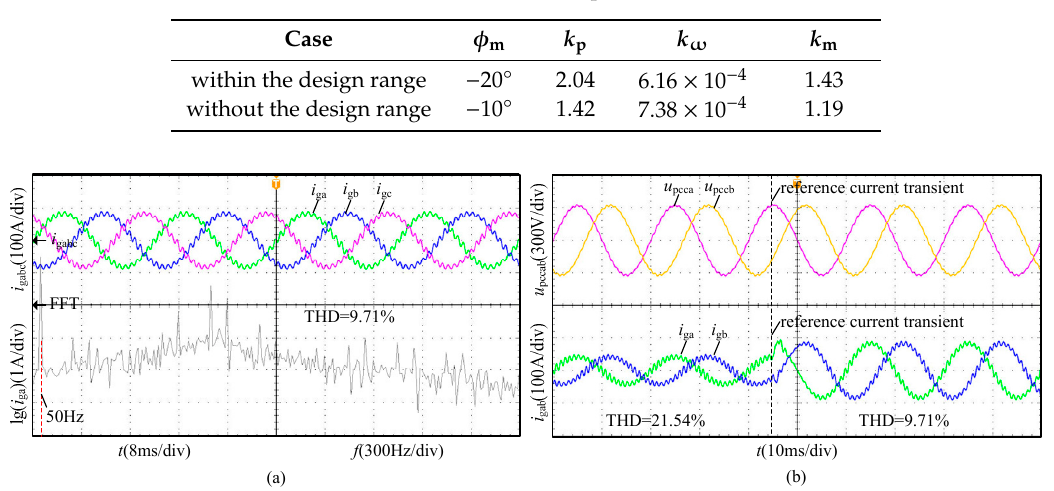
Figure 15. Experimental waveforms of point of common coupling (PCC) voltage u pcc and grid-connected current i g with traditional control method. ( a ) Steady state; ( b ) Transient.